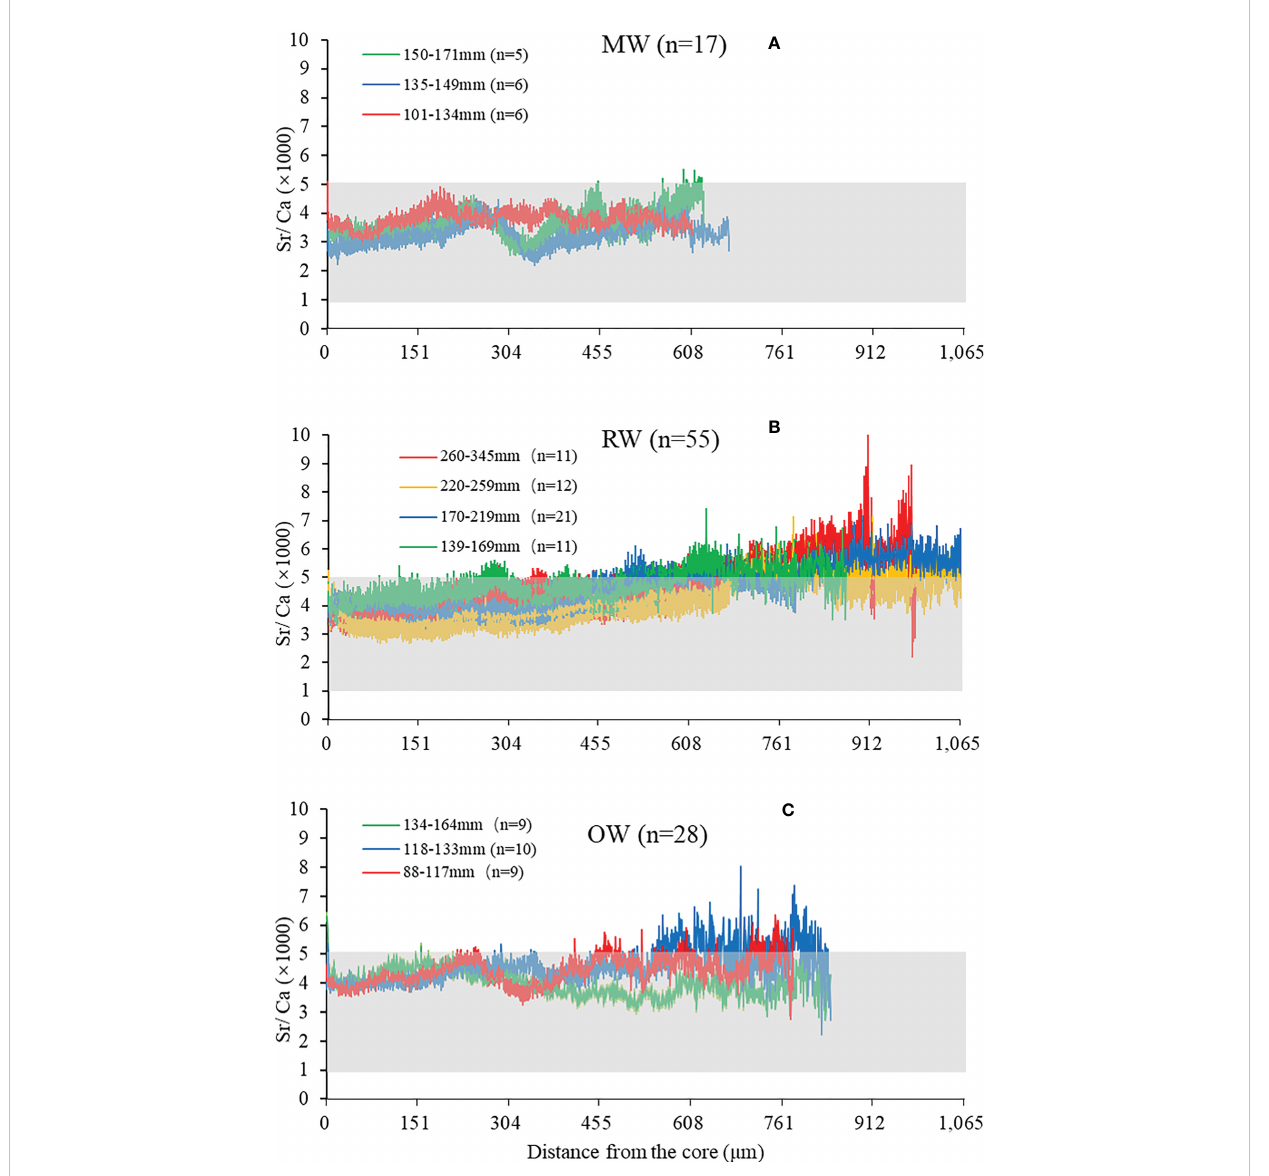
FIGURE 5 The Sr/Ca ratios (Mean±SE) along line transect from the core (0 m m) to the edge in the sagittal plane of A. latus otoliths from Wanshan islands. Grey areas are non-marine waters. The legend indicates the range of body lengths for each groups and n indicates the number of samples in group. (A) A. latus from MW, (B) A. latus from RW, (C) A. latus from